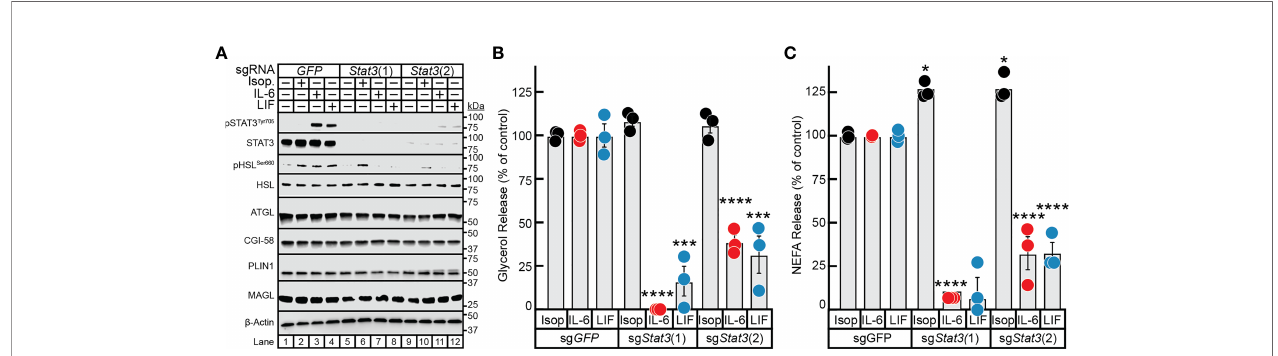
FIGURE 5 | The Role of STAT3 in IL-6 and b -adrenergic Adipocyte Signaling and Lipolysis. (A – C) Pre-adipocytes in a 12-well format were infected with lentivirus containing Cas9 and the indicated sgRNA as described in Methods . On day 8, differentiated adipocytes were treated in a fi nal volume of 1 ml of medium D with 3 µl DMSO and 3 µl PBS containing 300 nM isoproterenol, 3 nM IL-6, or 0.3nM LIF. After incubation for 24 hours, medium was collected and processed to measure concentrations of glycerol (B) or NEFA (C) and adipocytes were harvested and processed for immunoblot analysis (A) with the indicated antibodies as described in Methods . Glycerol release is shown relative to the respective stimulant in the sg GFP condition which were 366 m M, 70 m M, and 33 m M for isoproterenol, IL-6, and LIF, respectively. NEFA release is shown relative to the respective stimulant in the sg GFP condition which were 273 m M, 137 m M, and 34 m M for isoproterenol, IL-6, and LIF, respectively. Data is shown as mean ± SEM of three wells. * p < 0.5, *** p < 0.001, or **** p < 0.0001 based on two-way ANOVA with Tukey ’ s multiple comparison test for differences in relative glycerol or NEFA release between sgRNA treatments with the same stimulant. These results were con fi rmed in at least three independent